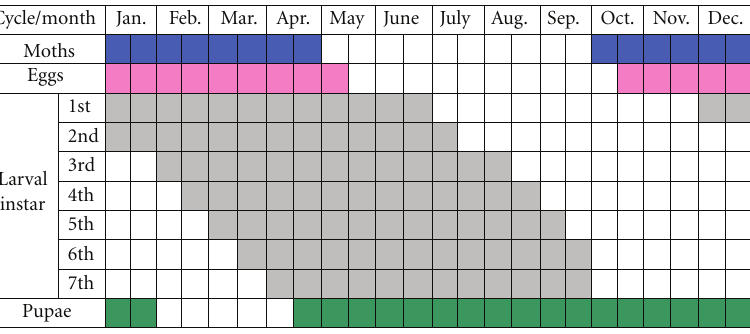
Figure 4: Time of occurrence of the various stages of Anaphe panda in the Kakamega Forest.